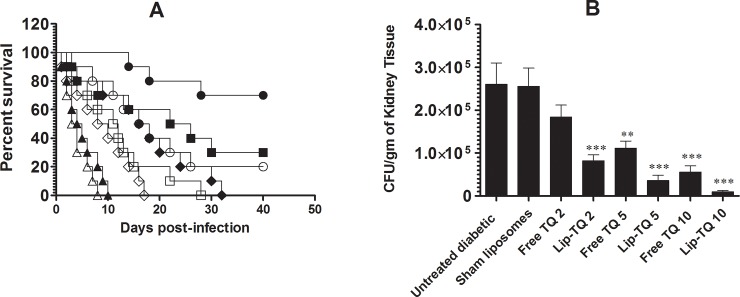
Treatment with Lip-TQ was effective against C. albicans infection in the diabetic mice.(A) The survival of C. albicans infected diabetic mice was observed for 40 days post treatment. Untreated diabetic (△), Sham Liposomes (▲), Free-TQ-2 mg/kg (◊), Lip-TQ-2 mg/kg (◆), Free-TQ-5 mg/kg (□), Lip-TQ-5 mg/kg (■), Free-TQ-10 mg/kg (○), Lip-TQ-10 mg/kg (●). Lip-TQ-10 mg/kg vs free TQ-10 mg/kg (P = 0.0136), Lip-TQ-5 mg/kg vs free TQ-5 mg/kg (P = 0.0356), (B) On day 4 post treatment, three mice from each group were sacrificed and their kidney were homogenized. The homogenates from an equally weighed kidney tissue were cultured to determine the fungal load. Values are expressed as mean ± SD from kidney from three different mice. A P value <0.05 was considered to be significant.